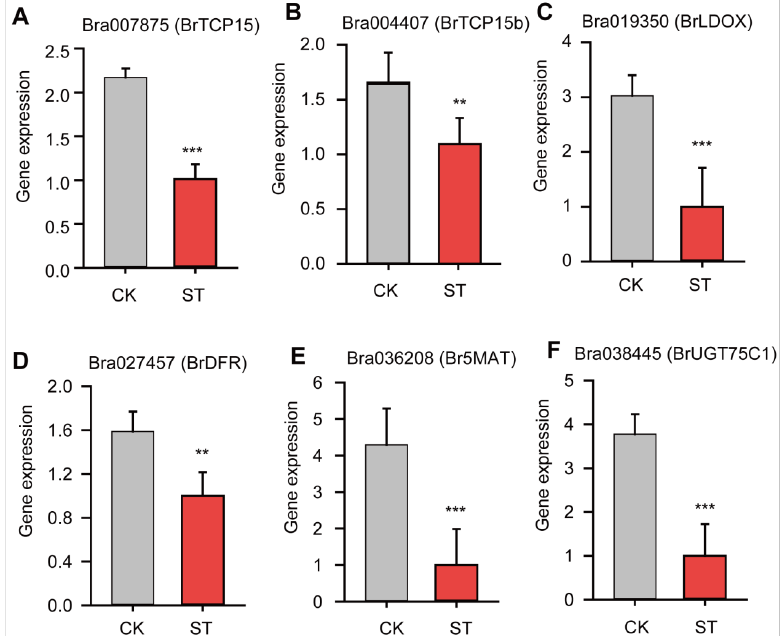
Figure 5. Differential expression of key genes induced by low light treatments in XH1 cai-tai seedlings. ( A – F ) q-RT-PCR testing the expression levels of genes, including Bra007875, Bra004407, Bra019350, Bra027457, Bra036208 and Bra038445, respectively. The q-RT-PCR experiments were conducted with three biological replicates, and three technical replicates for each biological replicate. The significant levels were determined between control and low light treated samples using t -test, at p < 0.01, and 0.001 indicated by “**” and “***”, respectively. The primer of each gene was listed in Table S1.